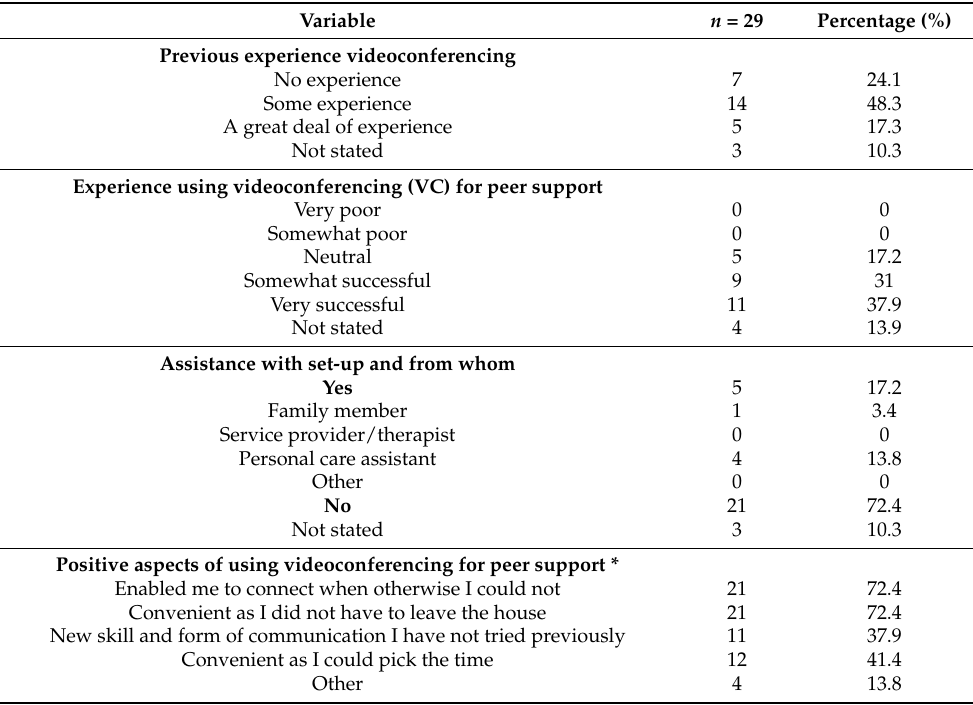
Table 2. Experience, benefits and challenges of using VC for peer